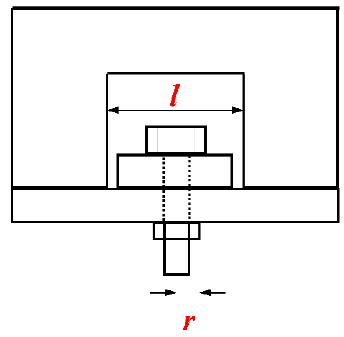
Figure 18. Diagram of variables r and l .